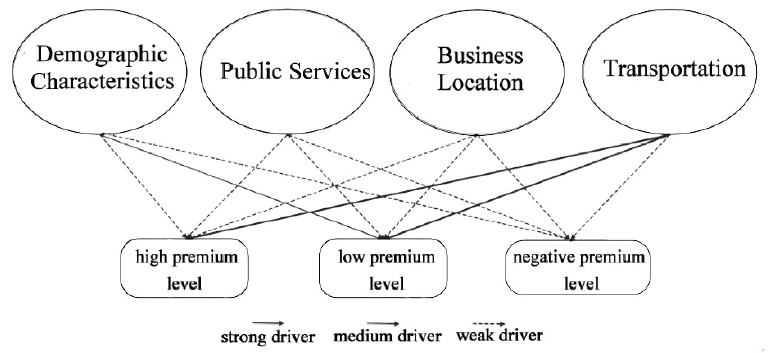
Figure 7. The mechanism whereby key factors influence housing premiums in urban